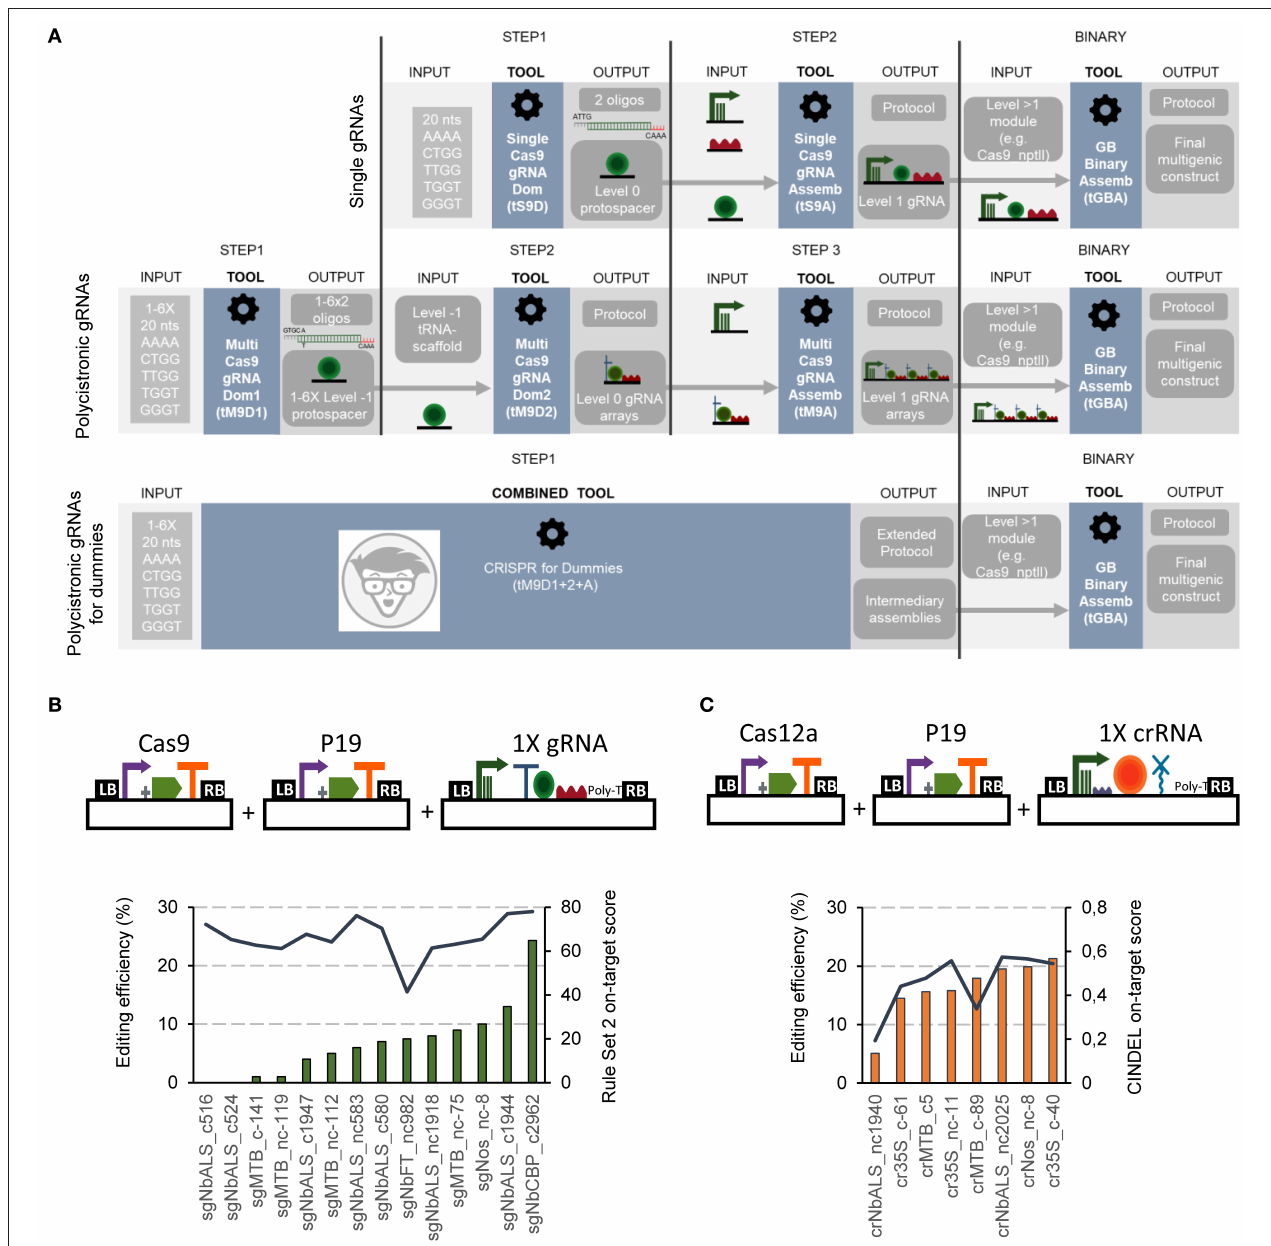
FIGURE 1 | Flowchart and functional validation of the software-assisted procedure for gRNAs cloning with GoldenBraid. (A) Schematic representation of the software tools for Cas9 gRNAs cloning. Single Cas9 gRNAs cloning is assisted via the Single Cas9_gRNA Domesticator ( tS9D ) and the Single Cas9_gRNA Assembler ( tS9A ) (top). Cas9 multiplexing gRNAs are assembled with the use of three consecutive software tools: the Multi Cas9_gRNA Domesticator 1 ( tM9D1 ), the Multi Cas9 gRNA Domesticator 2 ( tM9D2 ), and the Multiple Cas9_gRNA Assembler ( tM9A ) that creates Level 1 gRNA arrays (middle). The CRISPR for Dummies tool takes 1–6 protospacers as input and generates Level 1 gRNA arrays in a single step (bottom). (B) Correlation of Cas9 gRNAs predicted on-target scores and editing efficiencies tested in N. benthamiana transient expression. Schematic representation of the plasmids co-infiltrated in this experiment (top) and Cas9 guide RNAs editing efficiencies (left axis, bars, determined with ICE) and their corresponding on-target score (right axis, line) determined with the “Rule Set2 scoring” (bottom). (C) Correlation of Cas12a crRNAs predicted on-target scores and editing efficiencies tested in N. benthamiana transient expression. Schematic representation of the plasmids co-infiltrated in this experiment (top) and Cas12a guide RNAs editing efficiencies (left axis, bars, determined with TIDE) and their corresponding on-target score (right axis, line) determined with CINDEL (bottom).